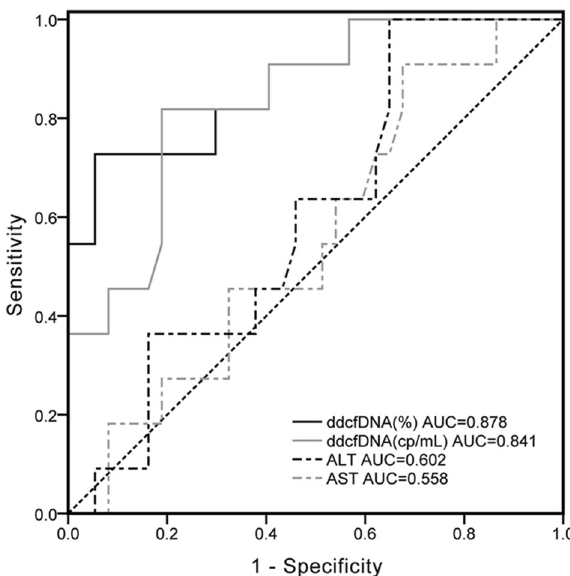
Figure 4. dd-cfDNA as a marker for pediatric liver transplant rejection. Black dotted diagonal represents the reference line. Black solid line represents the dd-cfDNA fraction (%) curve. Gray solid line represents the absolute quantitative (cp/mL) curve. Black dashed line represents ALT curve while gray dashed line represents AST curve.